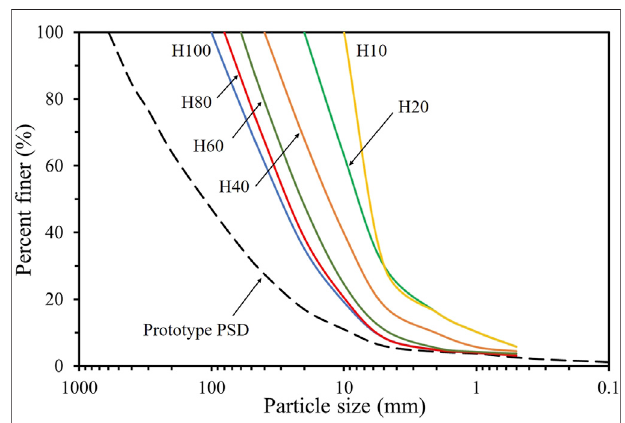
FIGURE 3 | DEM samples with three maximum particle sizes: (A) d M = 10 mm; (B) d M = 60 mm; (C) d M = 100 mm.